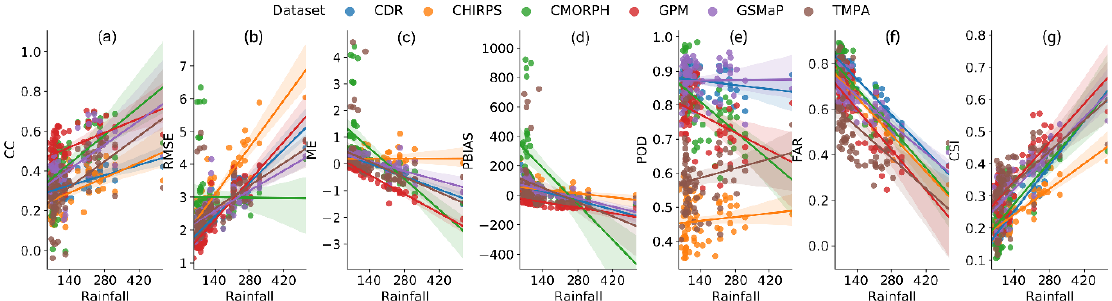
Figure 4. Datasets’ daily scale performance under different annual rainfall intensities (mm/a). ( a ) Correlation coefficient, ( b ) root mean square error, ( c ) mean error, ( d ) percentage bias, ( e ) probability of detection, ( f ) false alarm ratio, ( g ) critical success index.